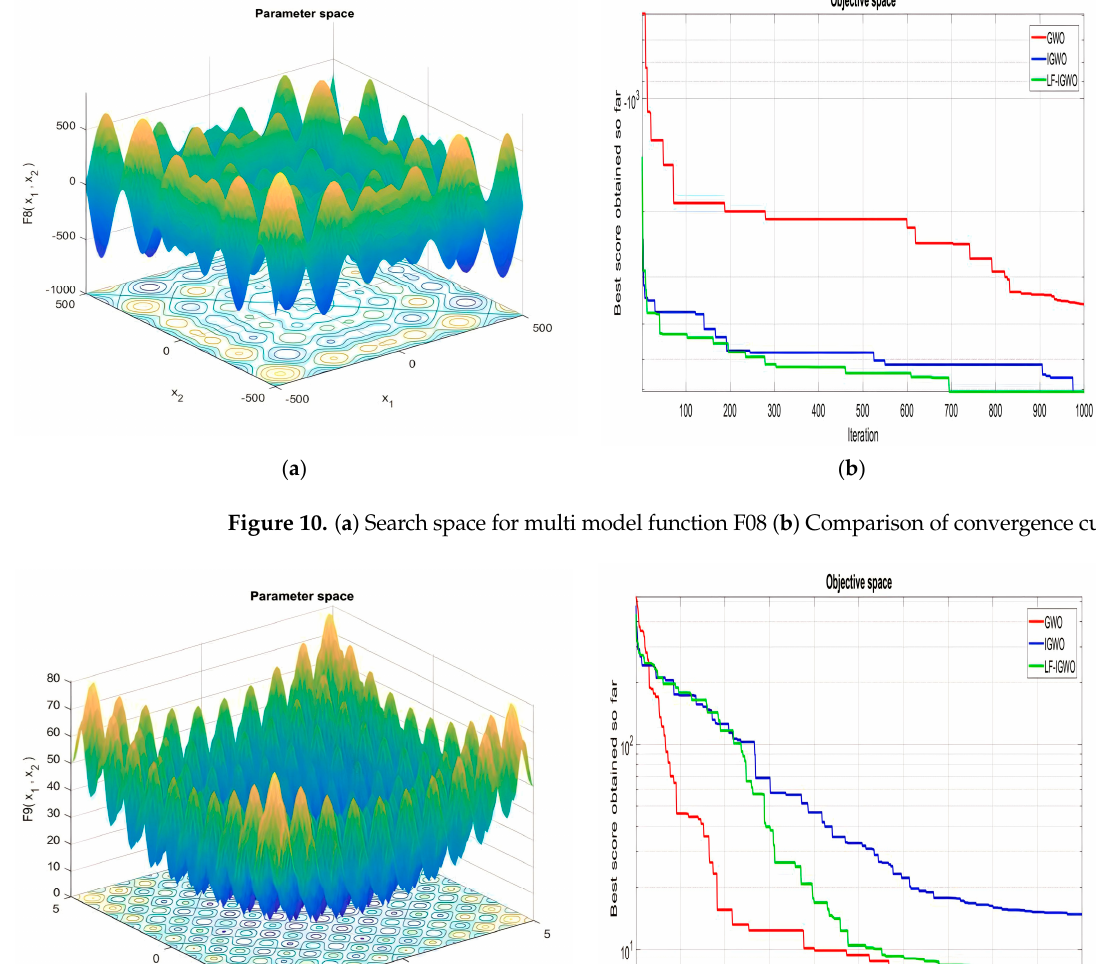
Figure 9. ( a ) Search space for unimodal function F07 ( b ) Comparison of convergence curve for F07.